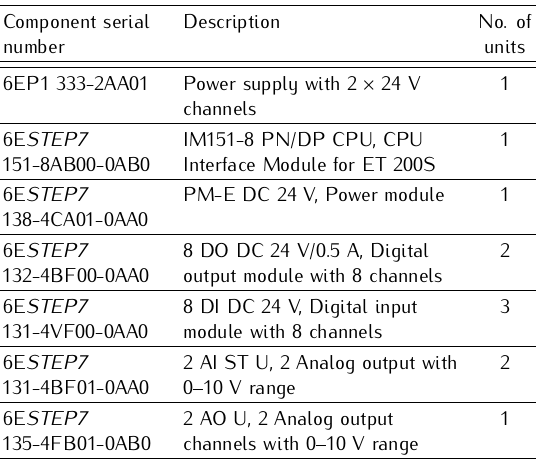
Table 1. Example setup of 3 addresses defined as inputs and 3 as outputs.